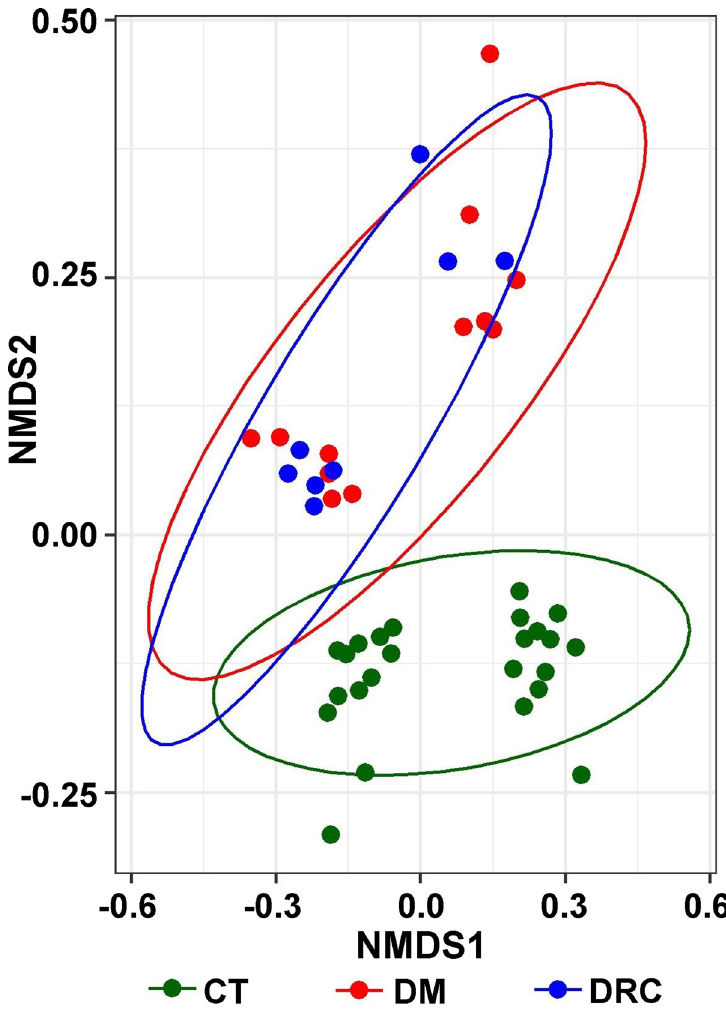
Fig 6. Two dimensional NMDS plot based on Canberra dissimilarity of mycobiomes at the genera level depicting significant β -diversity differences between control (CT1 –CT4, n = 24, green), diabetic rats (DM 1 and DM2, n = 12, red) and diabetic rats showing retinal changes (DRC1and DRC2 n = 8, blue) ( P = 0.001). The gut mycobiomes of CT and DM ( P = 0.001) and CT and DRC ( P = 0.001) respectively were significantly different but the mycobiomes of DM and DRC overlapped with each other ( P = 0.602). The P -value was calculated using